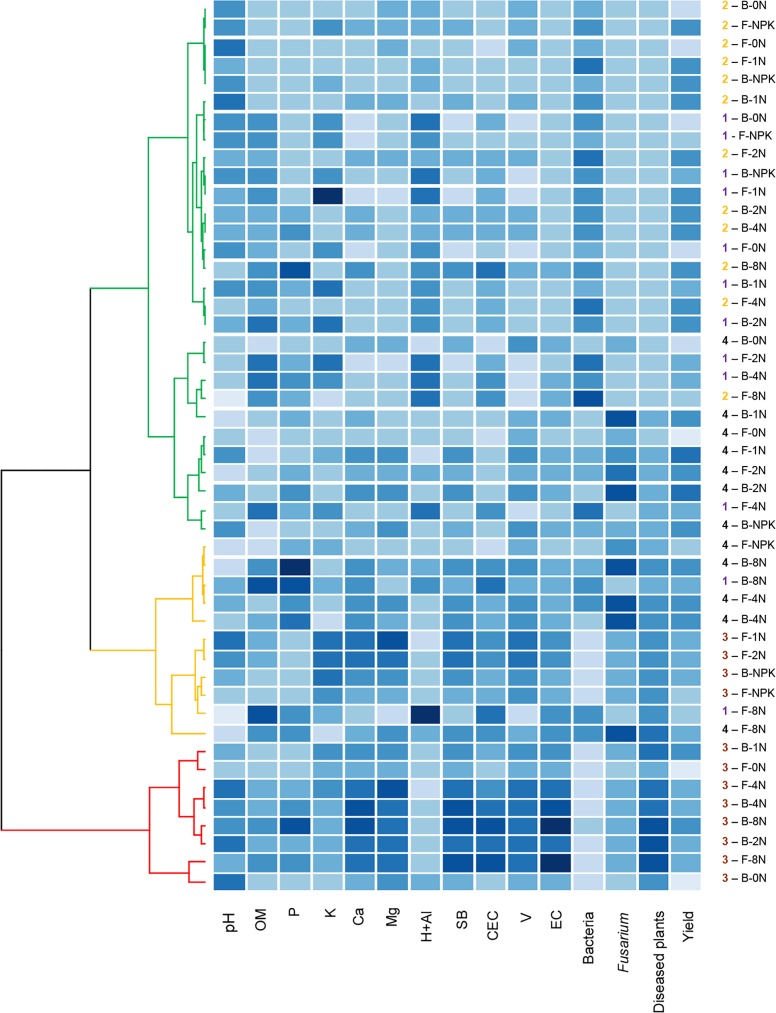
Dendrogram showing results of cluster analyses and heat map representation of disease, yield, and soil abiotic and biotic parameters amended with two types of sewage sludge.Dendrogram showing the results of the cluster analyses (red clusters represent high disease incidence, orange clusters represent intermediate incidence and green clusters represent low disease incidence) and a heat map representation of corn stalk rot incidence and yield and their relationship with soil abiotic (pH, OM, P, K, Ca, Mg, H+Al, SB, CEC, V, EC) and biotic parameters (bacterial and Fusarium populations) of soil treated with sewage sludge from Franca (F) and Barueri (B) at different dosages [0N, 1N, 2N, 4N and 8N, based on the N concentration that provided the same amount of N as the mineral fertilizer (NPK) recommended for corn] for years 1 (purple), 2 (orange), 3 (brown) and 4 (black). The blue intensity represents the mean value of the variable (higher values are represented by darker blue shades).